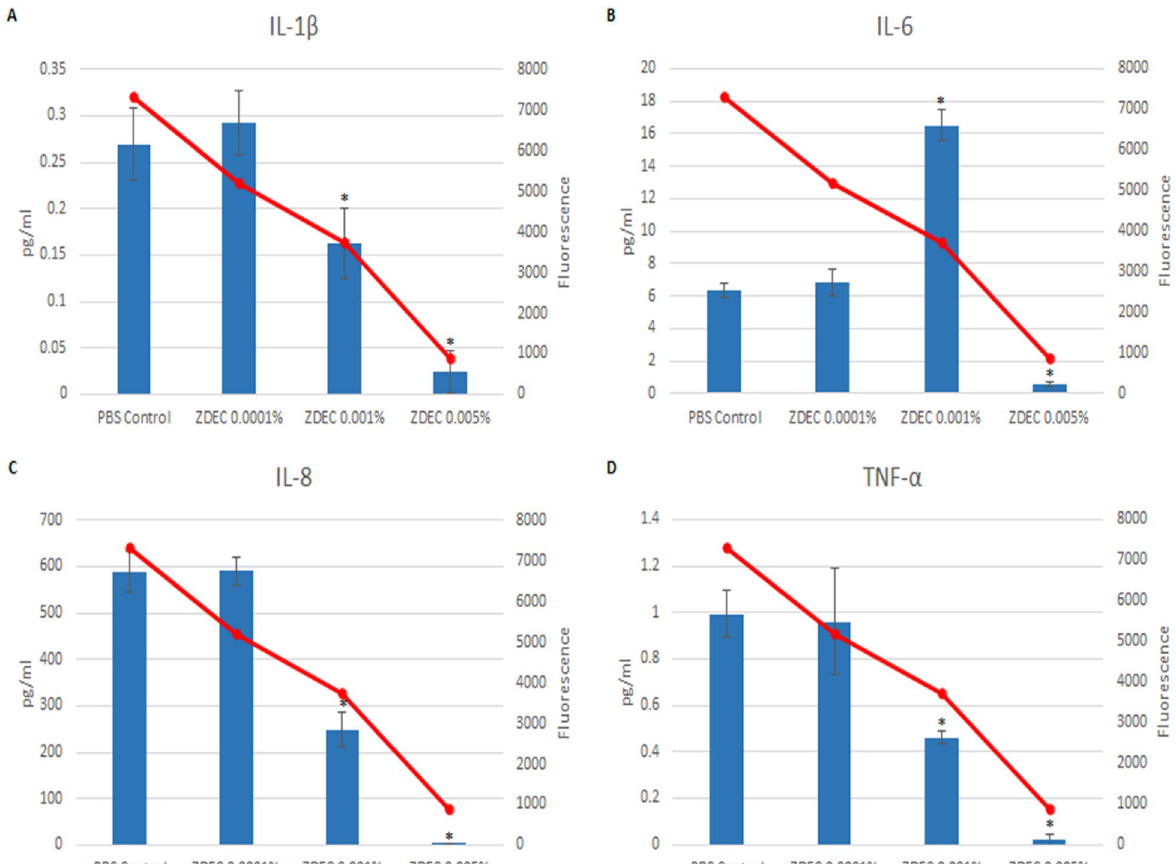
Figure 5. Cytokine release of ZDEC exposed HLEC. Release of four proinflammatory cytokines (bar graphs) and metabolic activity (line graphs) of HLEC exposed to ZDEC treated silicone discs. The four cytokines quantified are IL-1β ( A ), IL-6 ( B ), IL-8 ( C ), and TNF-α ( D ). *p < 0.05 of the PBS control. Error bars are the standard deviations. Experiments performed in triplicate in two separate